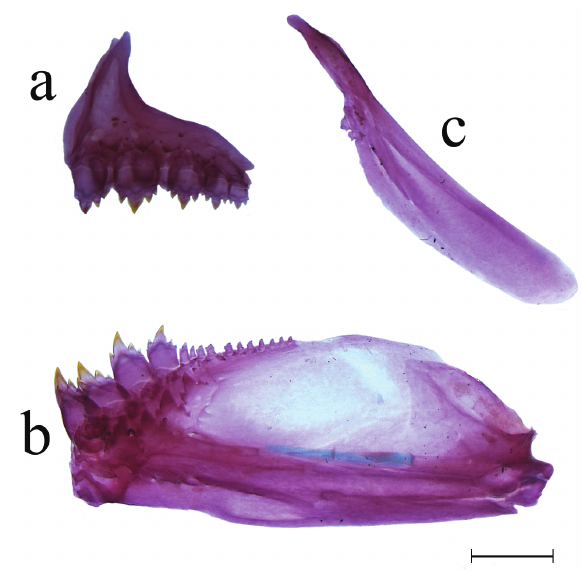
Figure 5. Moenkhausia britskii , MZUSP 17537, paratype: ( a ) premaxilla; ( b ) dentary; ( c ) maxilla. Medial view. Scale bar = 1 mm.